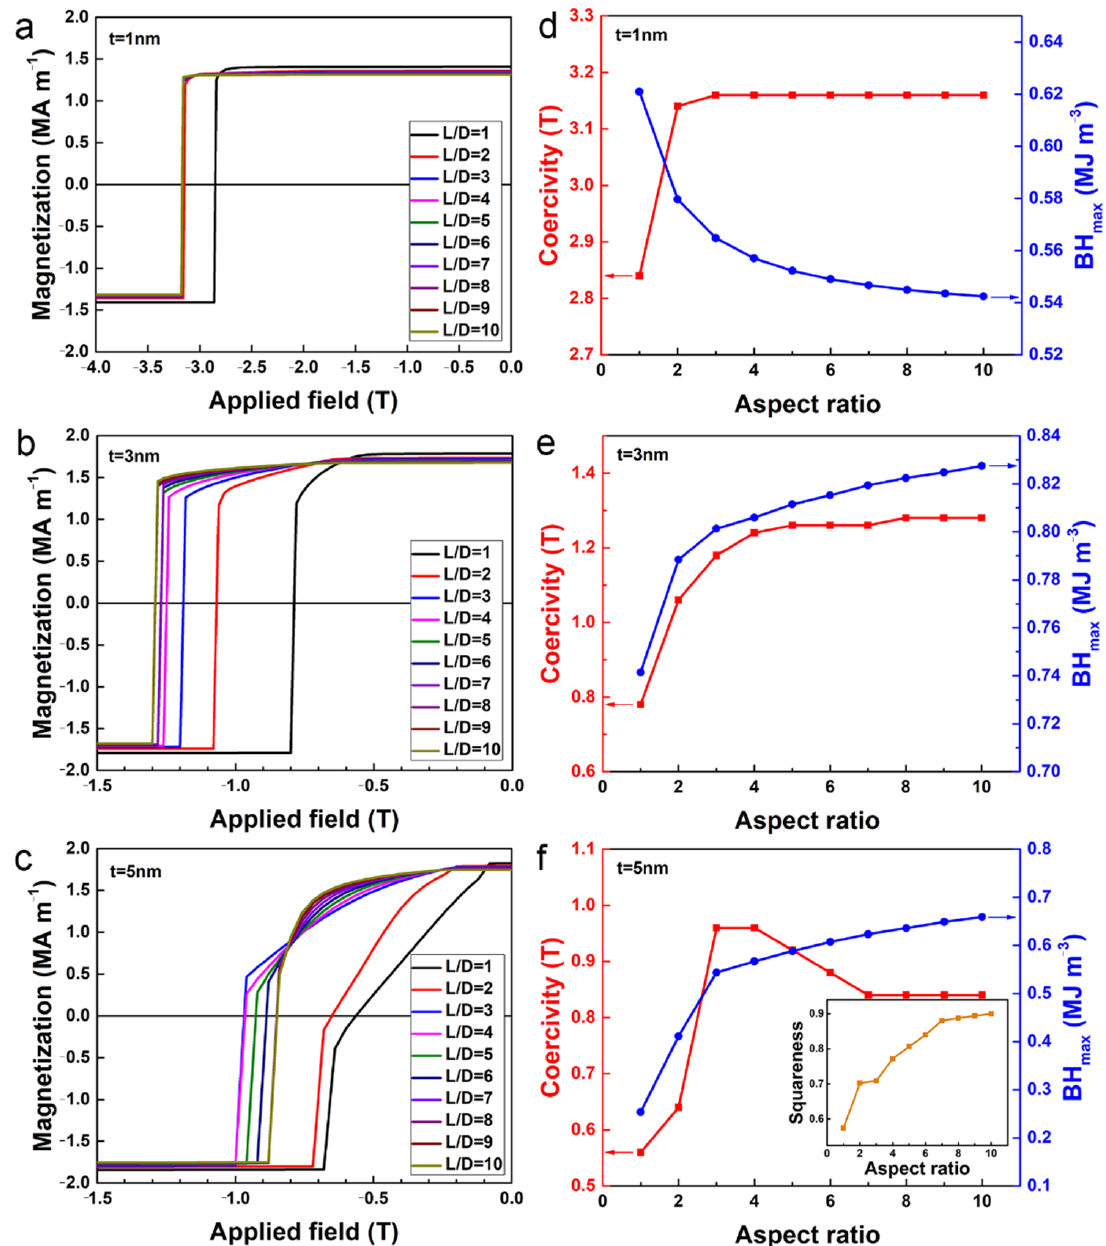
Figure 4. ( a – c ) Calculated demagnetization curves of core/shell cylinders for different aspect ratio with ( a ) t = 1 nm, ( b ) t = 3 nm, ( c ) t = 5 nm. ( d – f ) The coercivity (red) and maximum magnetic energy product ( BH ) max (blue) of core/shell cylinder with ( d ) t = 1 nm, ( e ) t = 3 nm, ( f ) t = 5 nm, shown as a function of aspect ratio. The inset in ( f ) shows the squareness as a function of the aspect ratio. In order to understand the details of magnetization reversal mechanisms in core/shell cylinders associated with different aspect ratios, the revolution of the magnetic